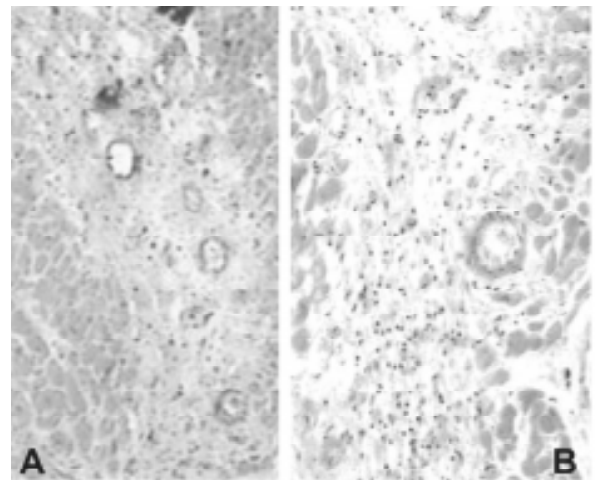
magnification).Figure 4. A. Microphotography of the myocardium adjacent to coronary artery exhibiting an important inflammatory infiltration and fibrosis. Also vascular neoformation, edema and congestion can be observed (hematoxylin-eosin; 40X magnification). B. Magnification at 100X of the same specimen emphasizing the inflammatory